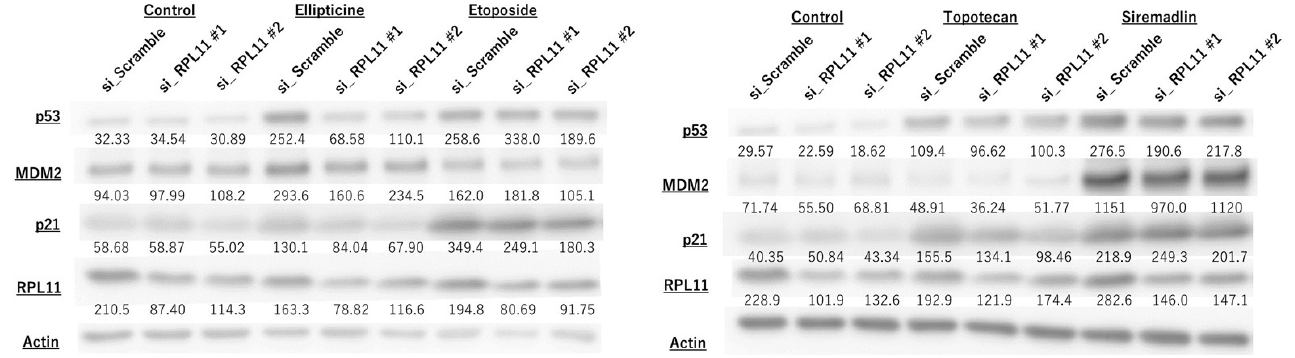
Figure 4. Nucleolar stress response regulates p53 pathway activation by topoisomerase inhibitors in rhabdomyosarcoma cells. RMS-YM cells were transfected with scramble, RPL11#1, and RPL11#2 siRNA and treated with indicated drugs (5 µM Ellipticine, 30 µM Etoposide, 1 µM Topotecan, 0.3 µM Siremadlin). After 4 h of culture, the cell lysate was subjected to immunoblotting with antibodies against p53, MDM2, p21, RPL11, and Actin. Actin was used as a loading control. The numbers below the bands indicate the ratio protein/actin expression determined using LuminoGraphII Image Analyzer with CS Analyzer 4 Software. Results represent independent four experiments.